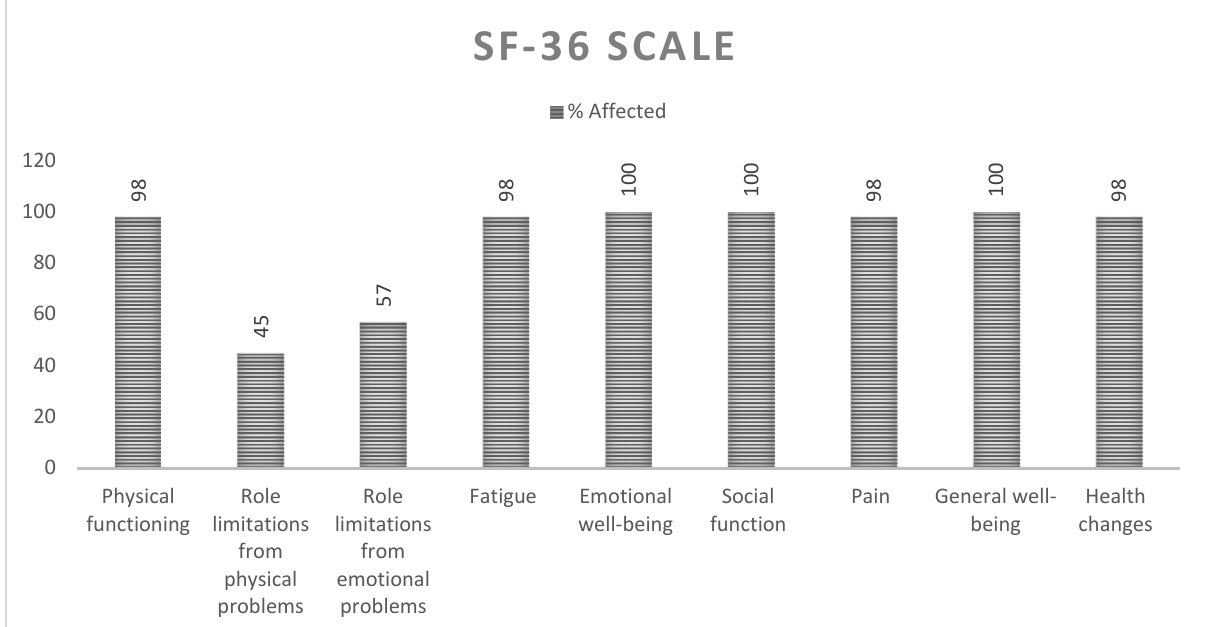
Figure 4. SF-36 questionnaire results.